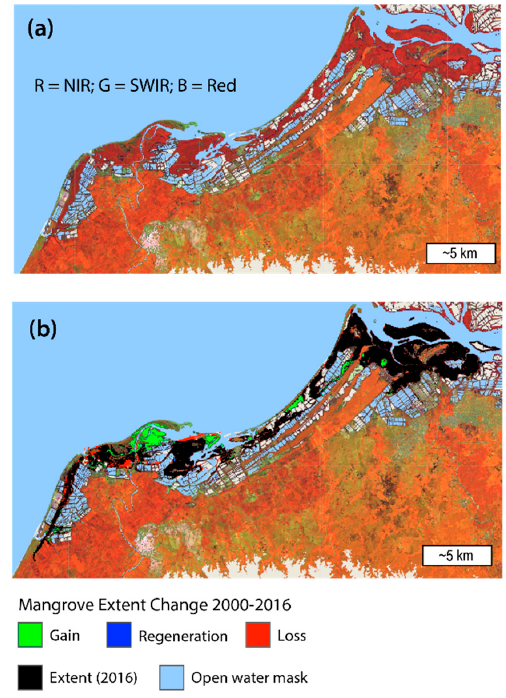
Figure 7. ( a ) The near-infrared (NIR), short-wave infrared (SWIR), and red bands from Landsat 8 Operational Land Imager (OLI) were used to make this 2016 false-color composite of the Tumbes District in Peru. ( b ) Changes in mangrove cover in Tumbes District in Peru between 2000 and 2016.